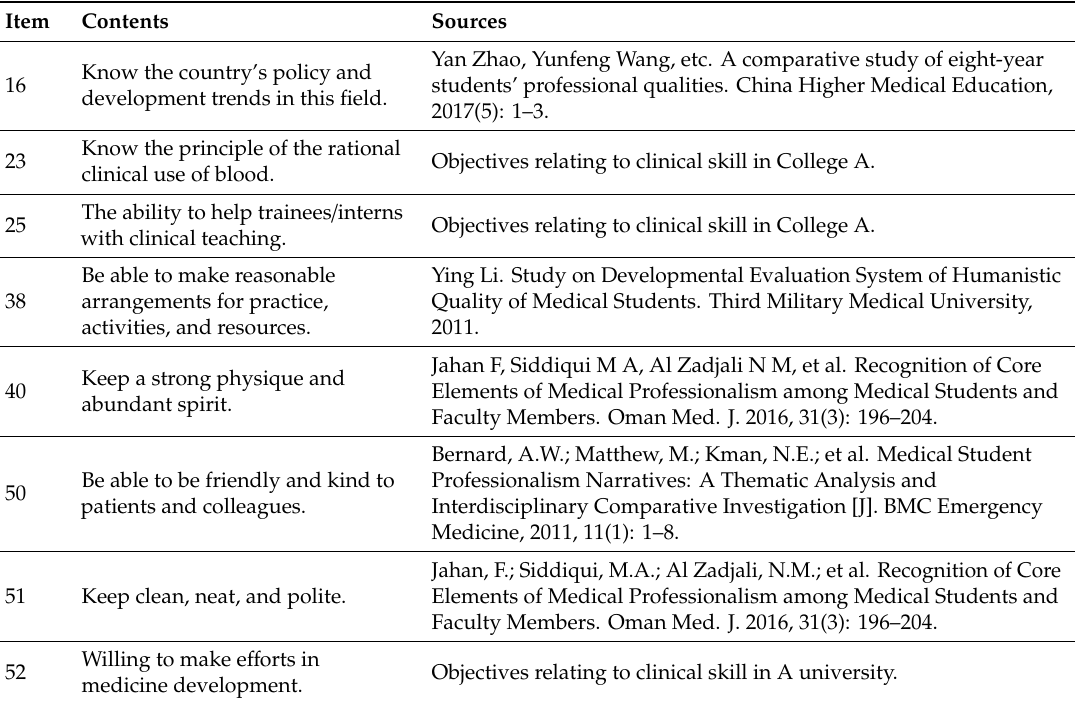
Table A1. Supplementary items and their sources.